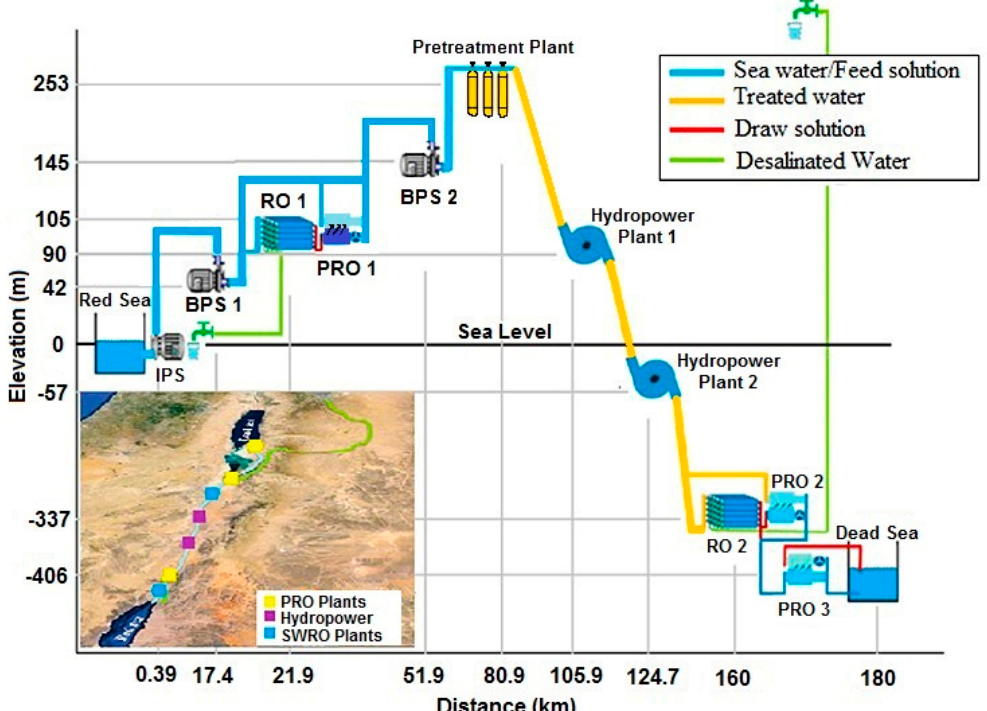
Figure 4. Flow diagram of the proposed RSDS project with three proposed PRO plants (RSDS infrastructure with distance and elevation [26]).